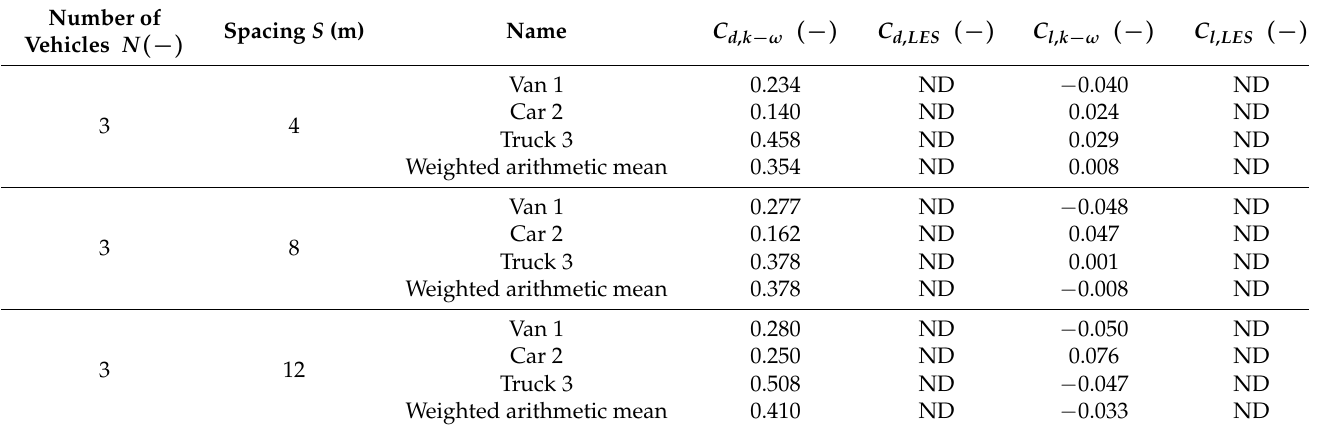
Table A1. Drag coefficient and lift coefficient of vehicles in heterogeneous columns